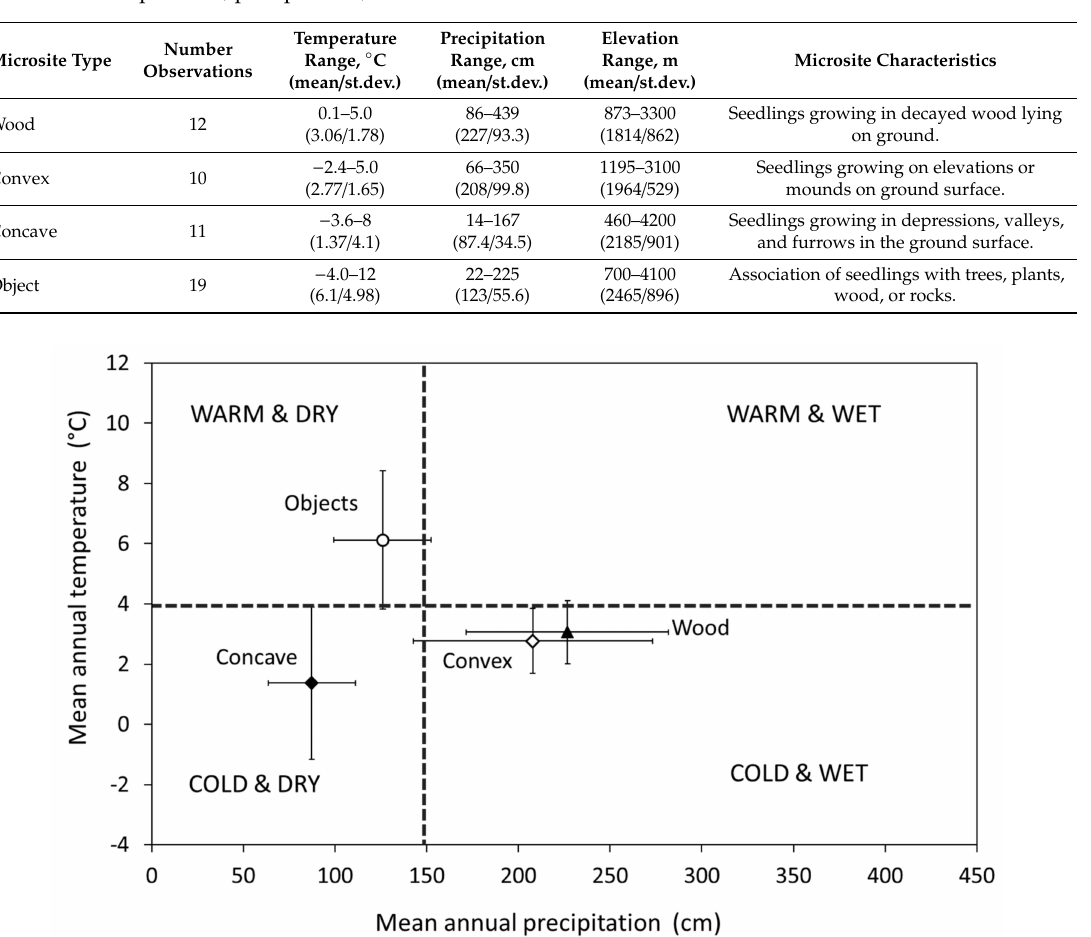
Table 1. Alpine treeline ecotone (ATE) microsite types enhancing seedling regeneration with mean annual temperature, precipitation, and elevation.